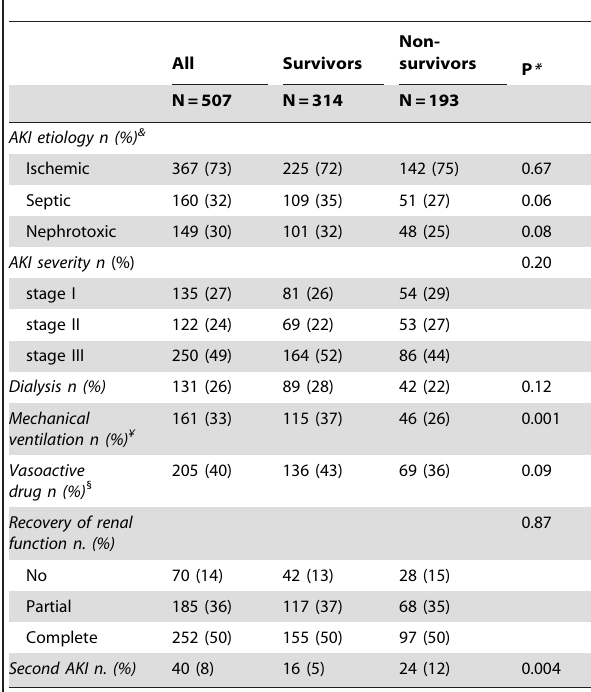
Second AKI n. (%) 0.004 *Comparison between survivors and non-survivors, Fisher’s exact test or chi- square. AKI, acute kidney injury; n , number of patients; & missing data in 7 patients. ¥ missing data in 21 patients. 1 missing data in 1 patient.